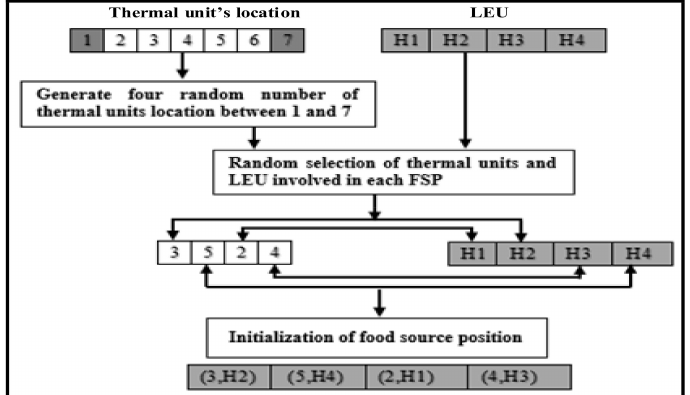
(cid:12) (cid:12) (cid:12) FSP k , n